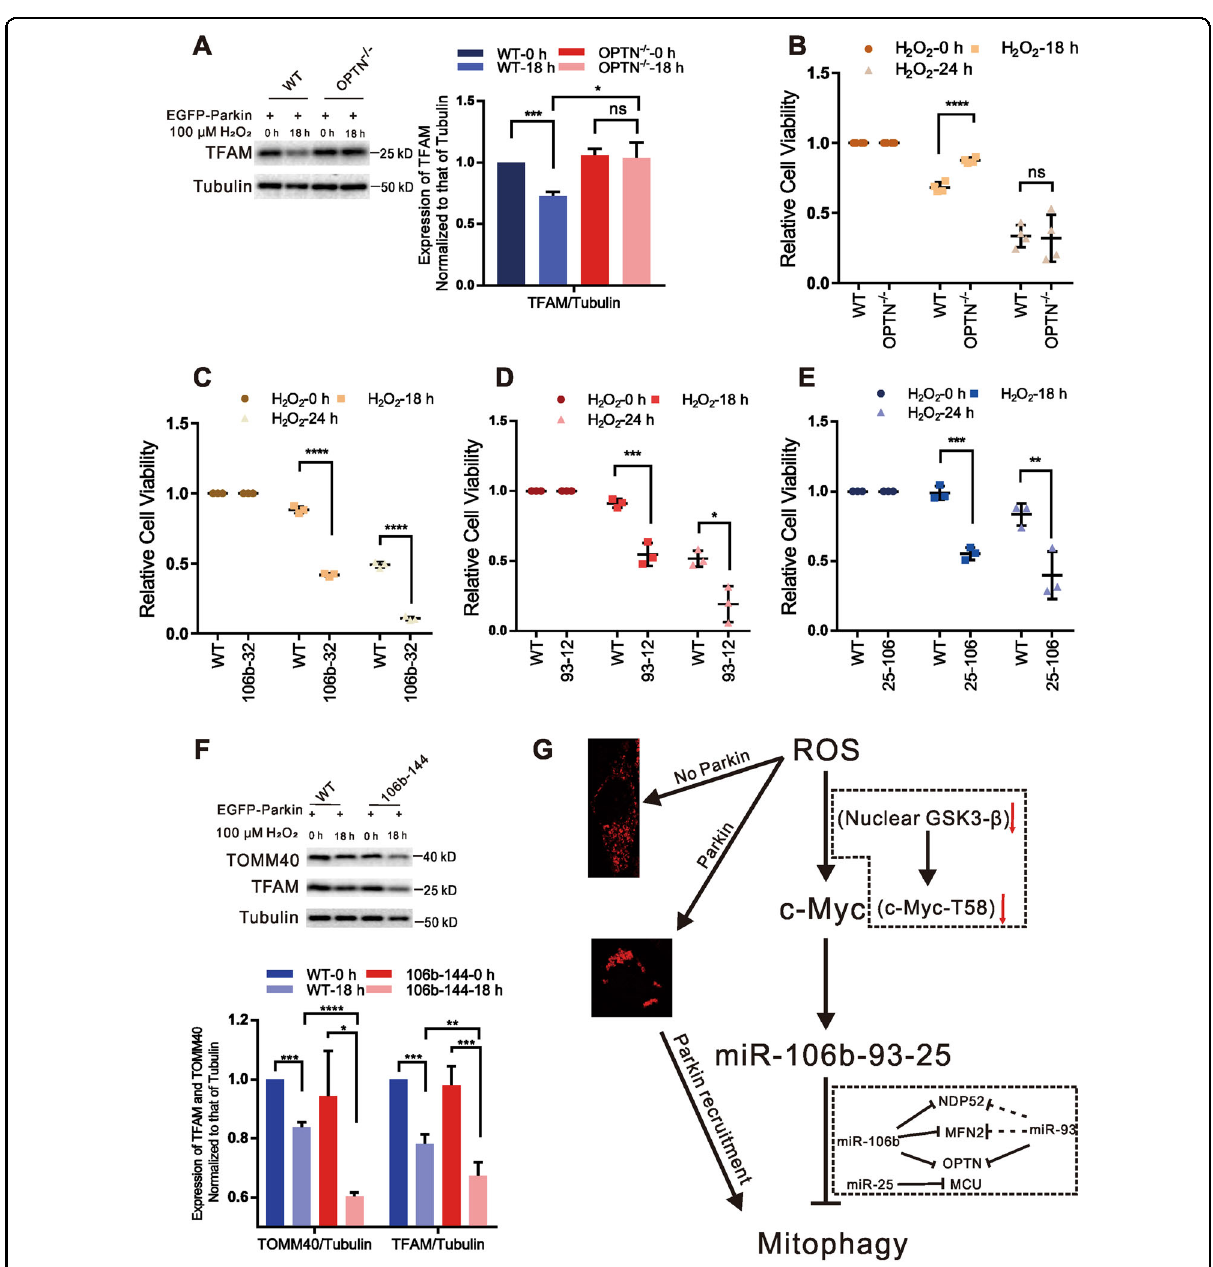
Fig. 7 The miR-106b-93-25 cluster protects cells from excessive mitophagy. A EGFP-Parkin was transfected into WT and OPTN-KO HeLa cells for 24 h. WB analysis of TFAM was performed after 0 – 18h of 100 μΜ H 2 O 2 treatment. Tubulin was used as an endogenous control. N = 3; ns, not signi fi cant; * P < 0.05; *** P < 0.001. The data are from three independent tests and are presented as the mean±SD. B – E A WT cell line, an OPTN-KO HeLa cell line, a miR-106b-KO cell line (106b-32), a miR-93-KO cell line (93-12), and a miR-25-KO cell line (25-106) were transfected with the EGFP-Parkin plasmid. Cell viability was detected after H 2 O 2 induction (100 μΜ ; 0h, 18 h, or 24h). N = 4 or 3; ns, not signi fi cant; * P <0.05; ** P < 0.01; *** P < 0.001; **** P < 0.0001. The data are from three or four independent tests and are presented as the mean± SD. F WT and miR-106b-KO (106b-144) cell lines transfected with EGFP- Parkin were induced with 100 μΜ H 2 O 2 for 0-18h and subjected to WB analysis with the indicated antibodies. N = 3; * P < 0.05; ** P <0.01; *** P <0.001; **** P < 0.0001. The data are from three independent tests and are presented as the mean± SD. G Mild and sustained H 2 O 2 stimulation modulates mitochondrial morphology and triggers mitophagy in a Parkin-dependent manner. Meanwhile, H 2 O 2 stimulation promotes transcription of the miR- 106b-93-25 cluster to regulate mitophagy-associated proteins. H 2 O 2 reduces GSK3 β levels in the nucleus, thus decreasing the phosphorylation of c-Myc at T58, producing an unstable form of c-Myc and resulting in increased c-Myc levels. The miR-106b-93-25 cluster, which is downstream of c-Myc, is increased along with c-Myc, thus inhibiting mitophagy-associated proteins (OPTN, NDP52, MFN2, and MCU) to protect against excessive